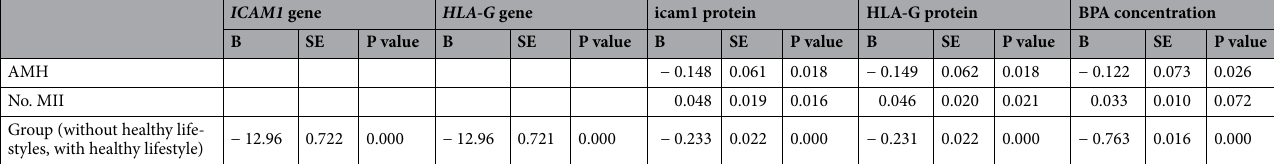
ICAM1 gene HLA-G gene icam1 protein HLA-G protein BPA